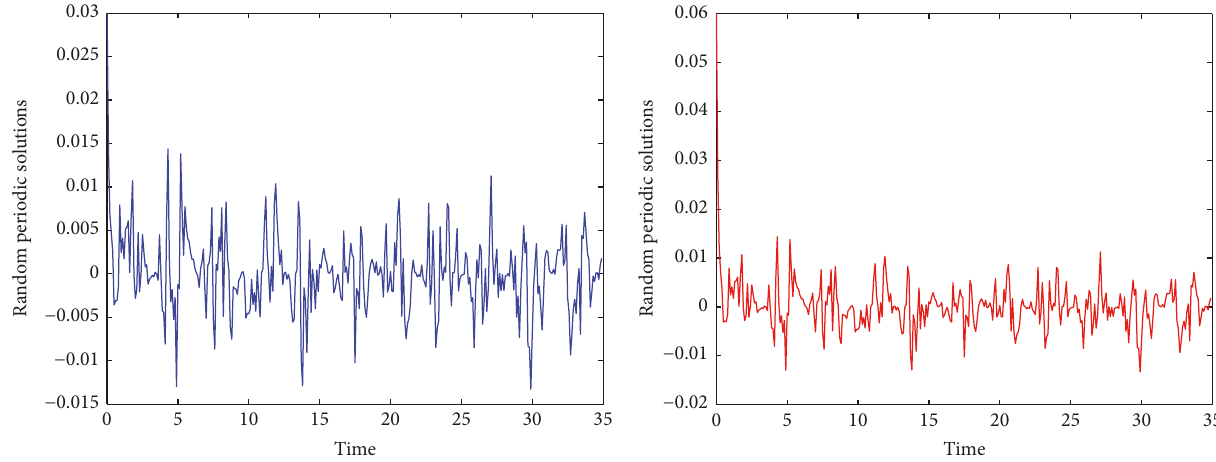
Figure 1: Random periodic solutions with the starting points 𝑋 0 = 0.03 and 𝑋 0 = 0.06 ; 𝜇 = 2 .